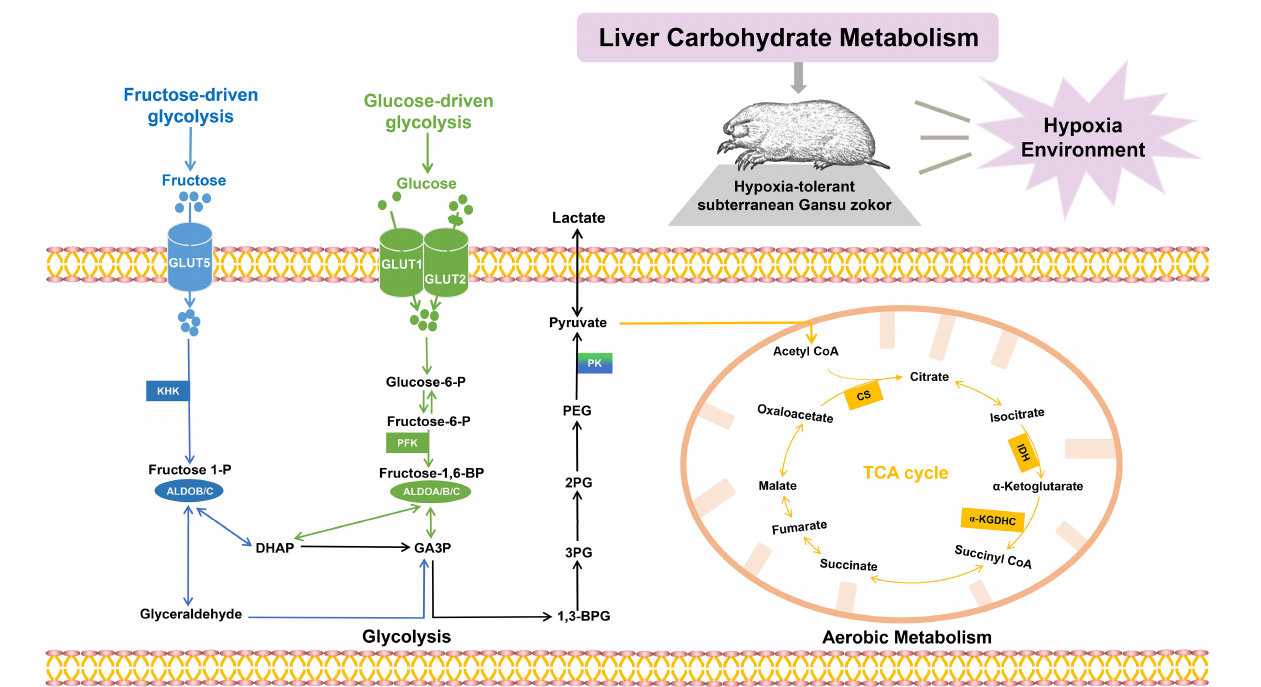
FIGURE 1 | The carbohydrate metabolic pathways. Glucose enters hepatic cells via GLUT1 or GLUT2 and is converted by phosphofructokinase and aldolases (PFK; ALDOA, ALDOB, and ALDOC; shown in green); fructose enters hepatic cells via GLUT5 and is converted by ketohexokinase and aldolases (KHK; ALDOB, and ALDOC; shown in blue). Pyruvate enters the mitochondria and undergoes a series of oxidative reactions via citrate synthase (CS), isocitrate dehydrogenase, and α -ketoglutarate dehydrogenase (CS, IDH, and α -KGDHC; shown in